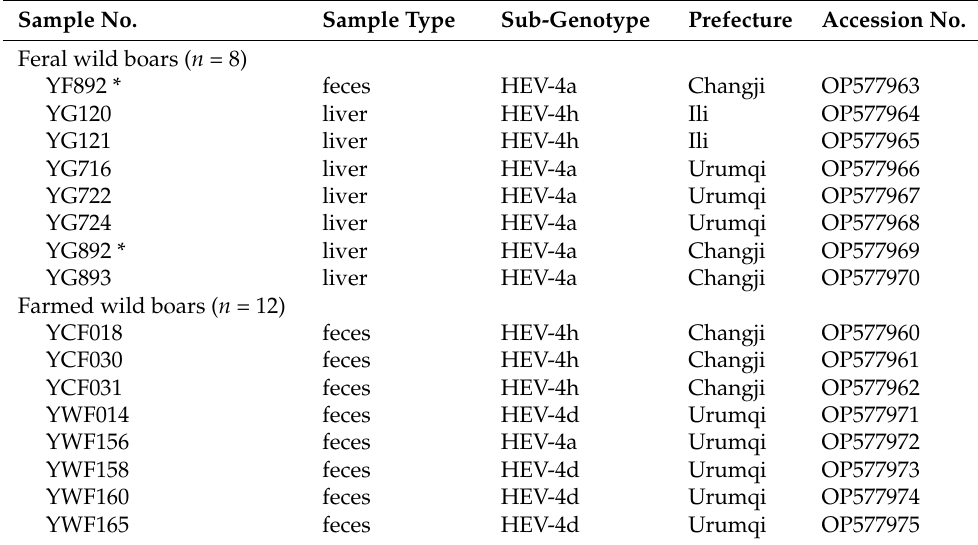
Table 4. Summary of HEV RNA-positive samples